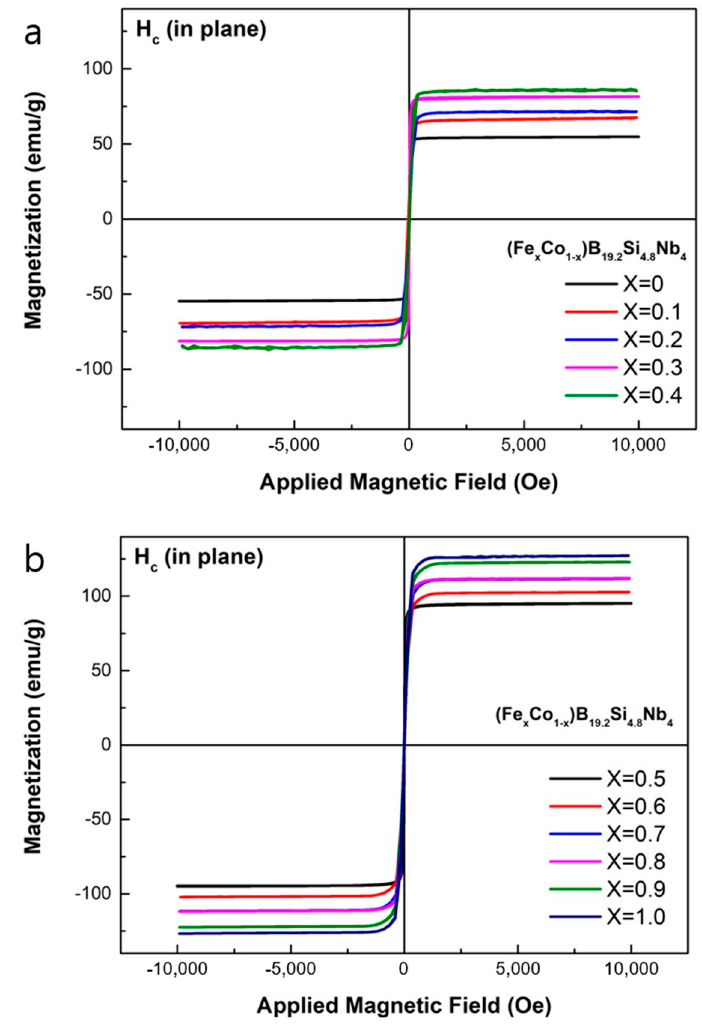
Figure 3. Hysteresis loops of the (Fe x Co 1 − x ) 72 B 19.2 Si 4.8 Nb 4 as-spun ribbons ( a ) 0 ≤ x ≤ 0.4 ( b ) 0.5 ≤ x ≤ 1.